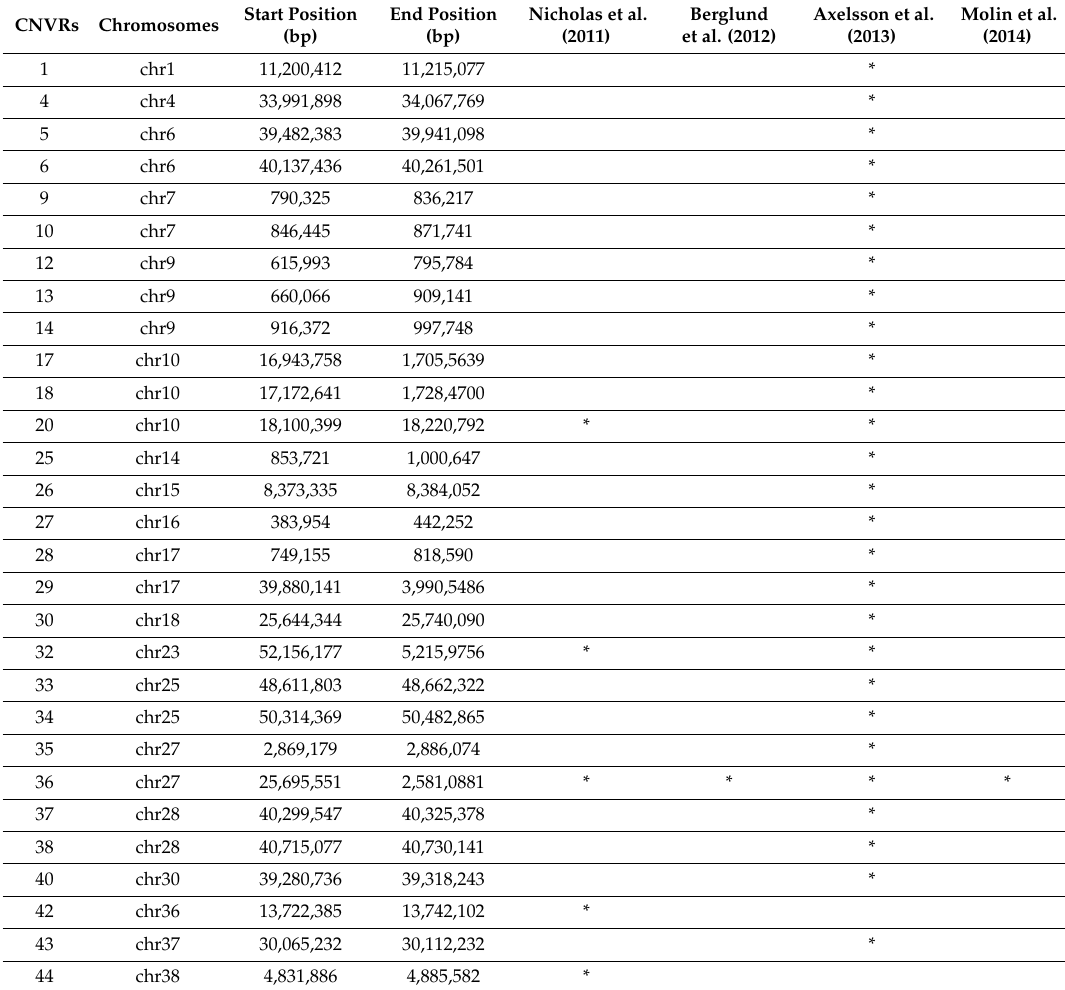
Table 1. List of copy number variation regions (CNVRs) detected in this study that overlapped with those reported in the literature. The symbol * shows the overlapping between